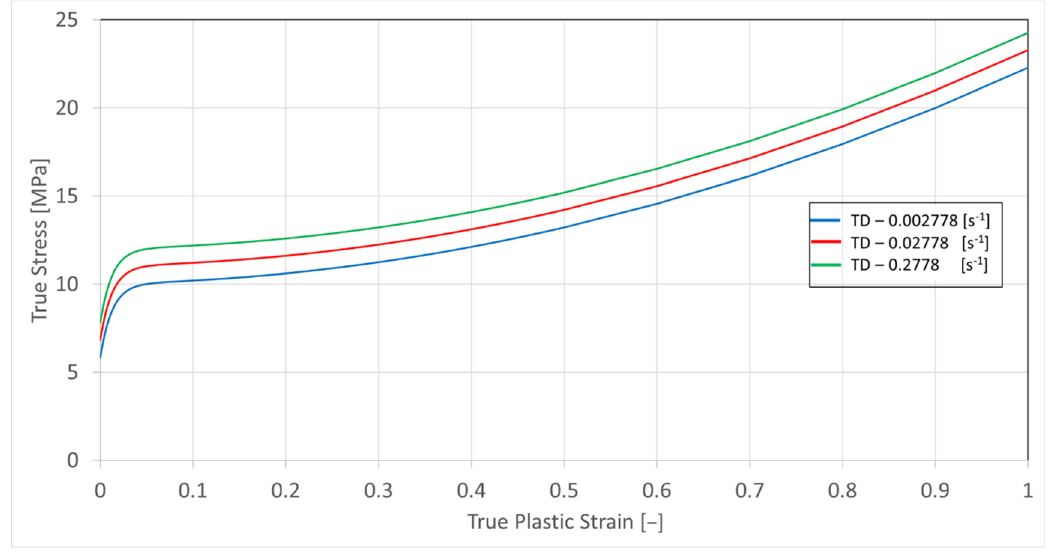
Figure 10. Fitted parametrized hardening curves resulting from test data for different strain rates in TD.